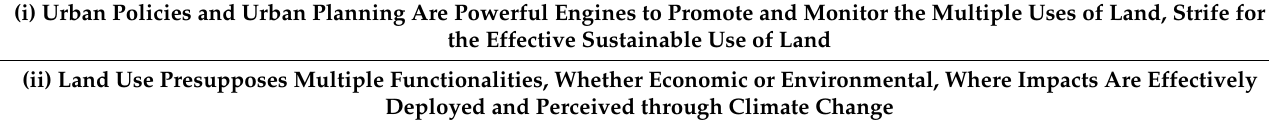
Table 2. Research propositions and environmental and economic